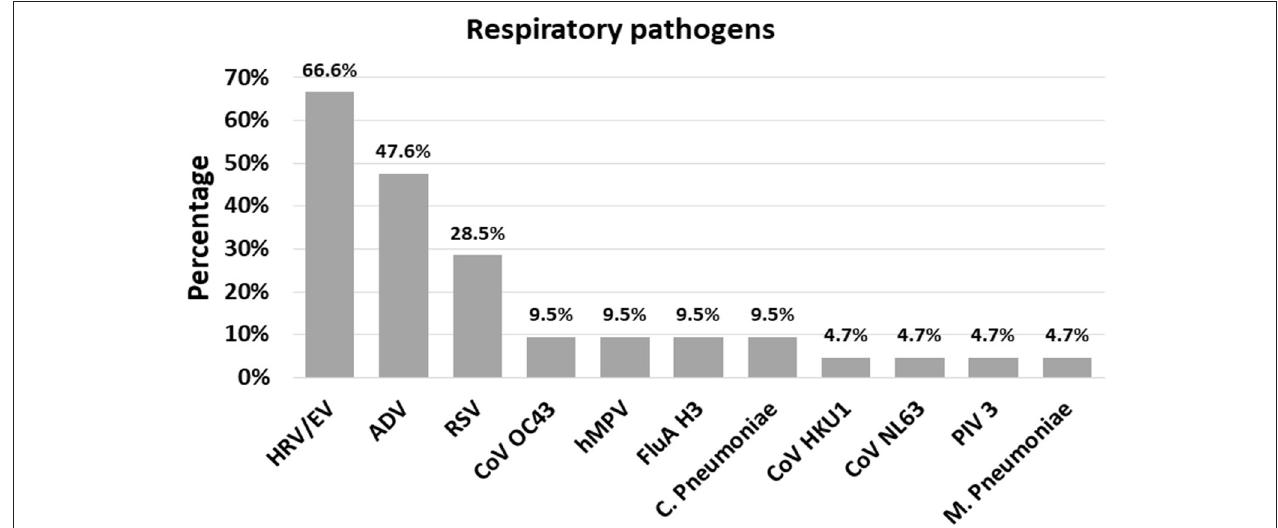
FIGURE 2 | The frequency (%) of each respiratory pathogen in the context of a co-infection. ADV, Adenovirus; CoV HKU1, Coronavirus HKU1; CoV OC43, Coronavirus OC43; CoV NL63, Coronavirus NL63; HRV/EV, Human Rhinovirus/Enterovirus; hMPV, Human Metapneumovirus; RSV, Respiratory Syncytial Virus; FluA H3, Influenza A H3; PIV 3, Parainflueza Virus 3; C. Pneumoniae, Chamydophila pneumoniae ; M. Pneumoniae, Mycoplasma pneumoniae .